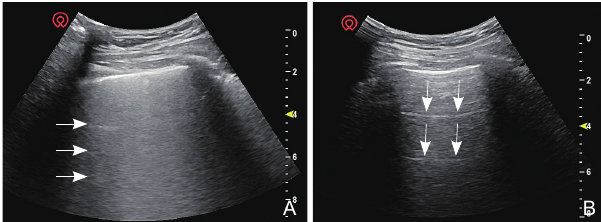
A Figure 2 Remote ultrasound images of lung. (A) Case 1, a 53-year-old female, on the day of admission, ultrasound showed multiple B3-lines in both lungs, which fused into each other to form "white lung" (arrow); (B) 24 days after admission, A-line (arrow) appeared in both lungs.